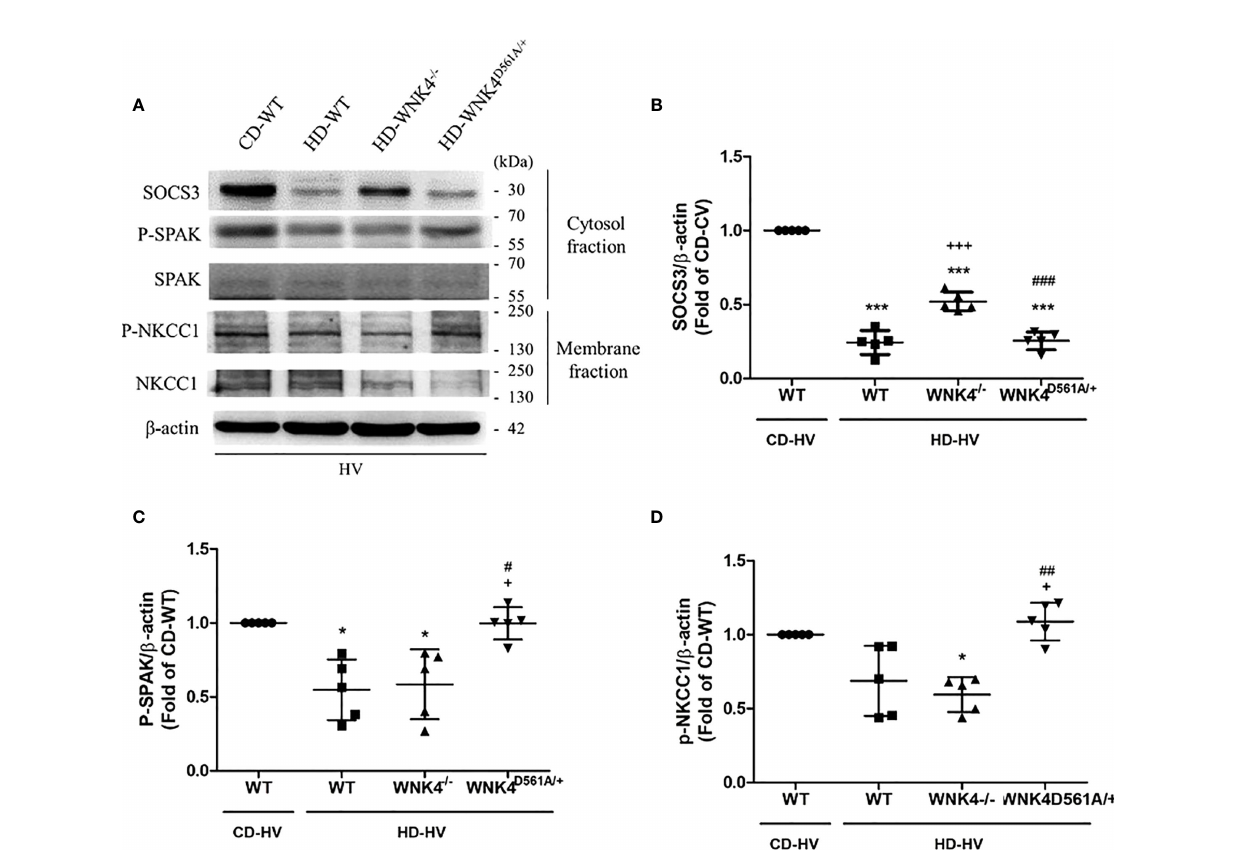
FIGURE 8 | Effect of obesity and WNK4 manipulation on the SOCS3 expression and the downstream WNK4 pathway after 6 h of mechanical ventilation (HV). These data were collected in nonobese wild-type mice (CD-WT), obese wild-type mice (HD-WT), obese mice with WNK4 knockout (HD-WNK4 − / − ), and obese mice with WNK4 knockin (HD-WNK4 D561A/+ ). (A) Western blotting. b -Actin served as a loading control for cytoplasmic proteins. Representative blots are shown. (B) SOCS3. (C) p-SPAK. (D) p-NKCC1. Data are expressed as the mean ± SE (n = 5 per group). * P < 0.05 and *** P < 0.001 compared with nonobese wild-type mice (CD-WT). + P < 0.05 and +++ P < 0.001 compared with the obese wild-type mouse group (HD-WT). # P < 0.05, ## P < 0.01 and ## P < 0.01 compared with obese mice with WNK4 knockout (HD-WNK4 − / −